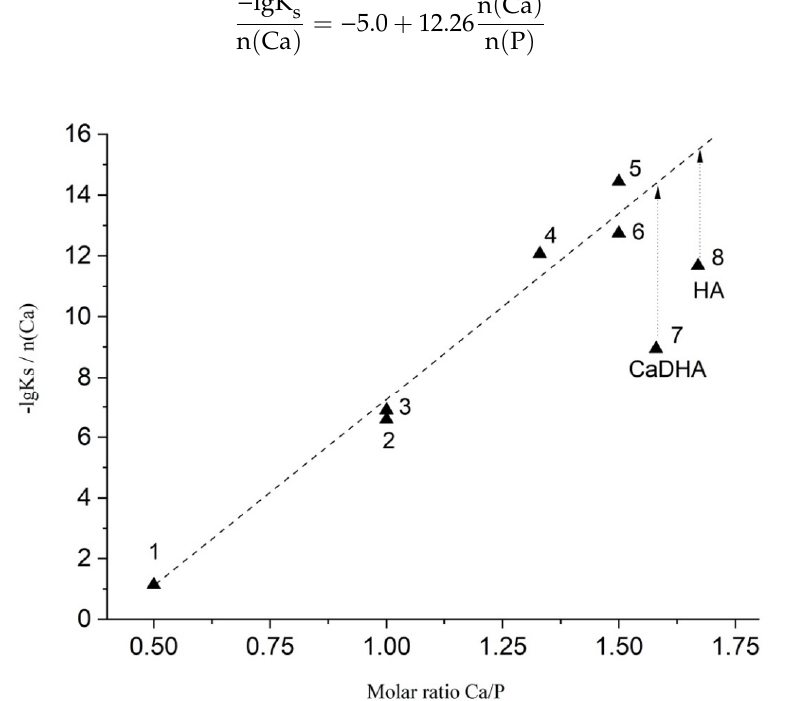
Figure 4. Comparison of the specific solubility product values of the calcium orthophosphates